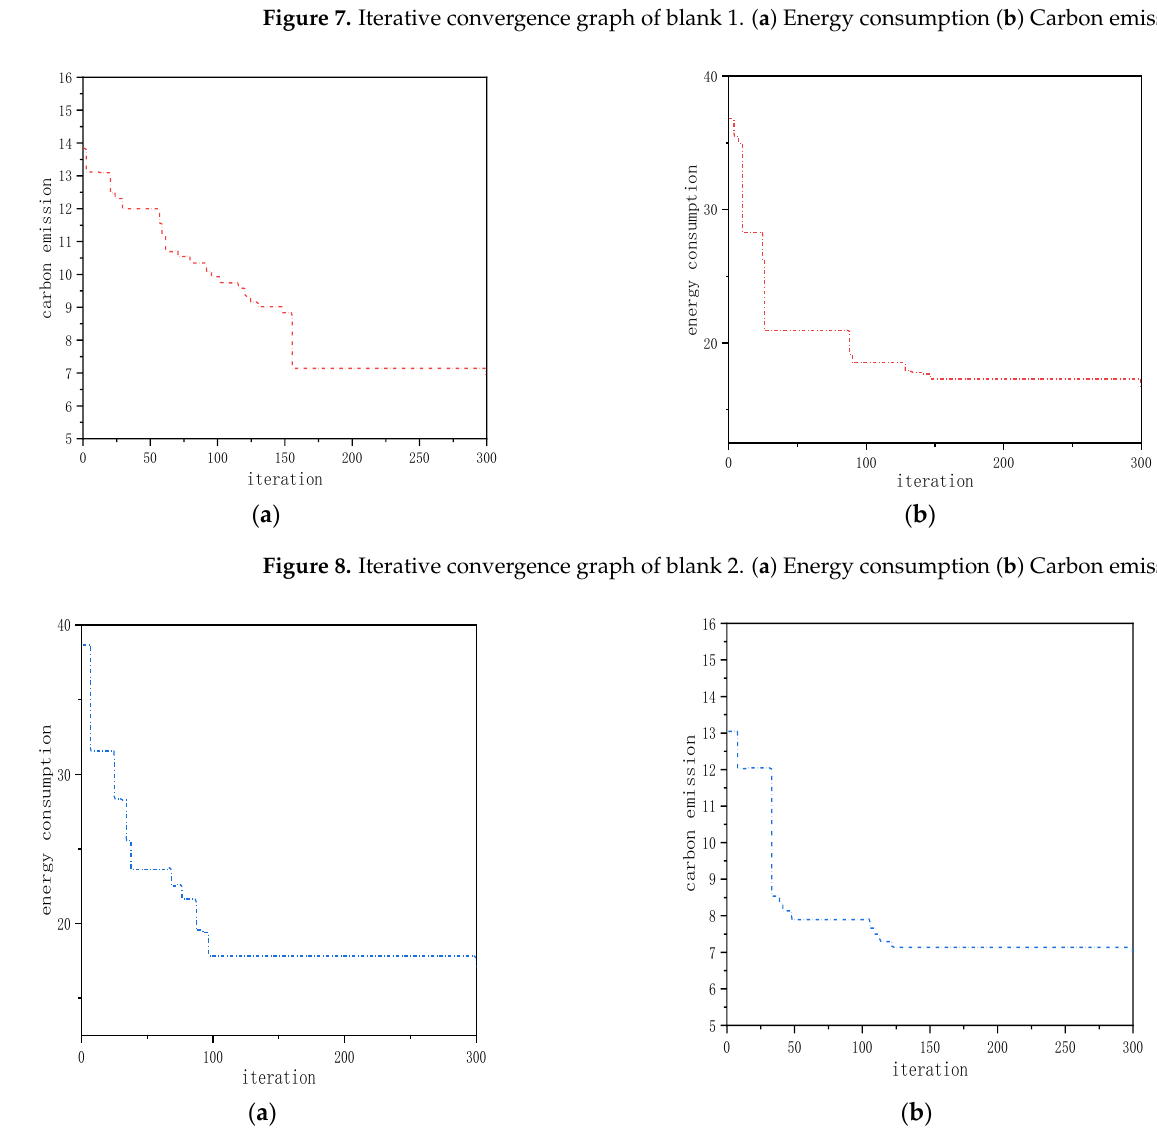
Figure 9. Iterative convergence graph of blank 3. ( a ) Energy consumption ( b ) Carbon emission.